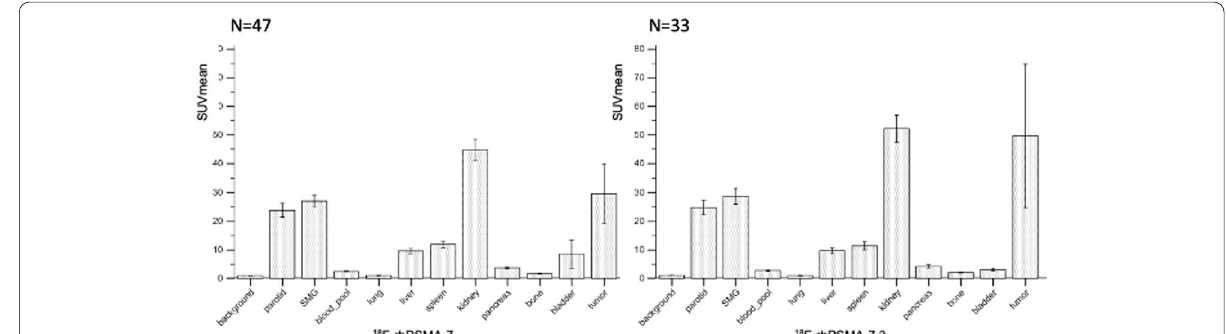
Fig. 1 Human biodistribution in normal organs and tumours of 18 F‑rhPMSA‑7 (A) and 18 F‑rhPSMA‑7.3 using SUVmean. SMG: submandibular gland